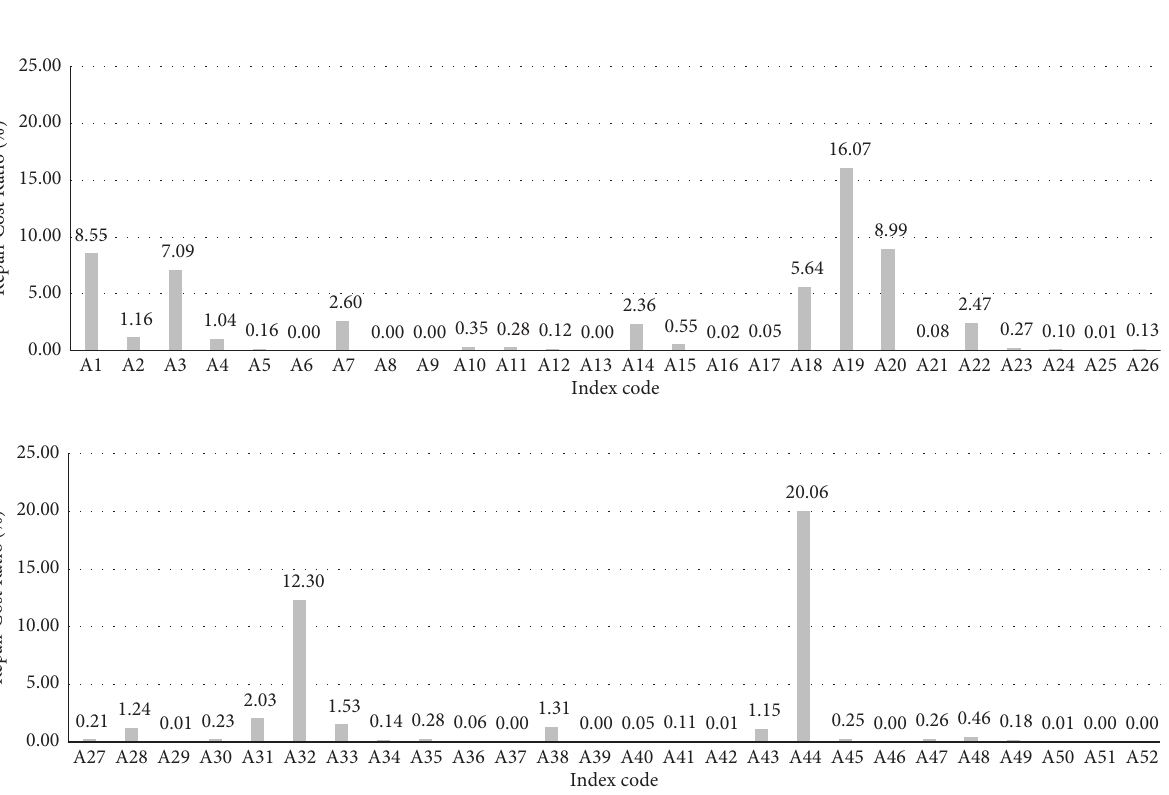
Figure 7: Issued case quantities of index A .